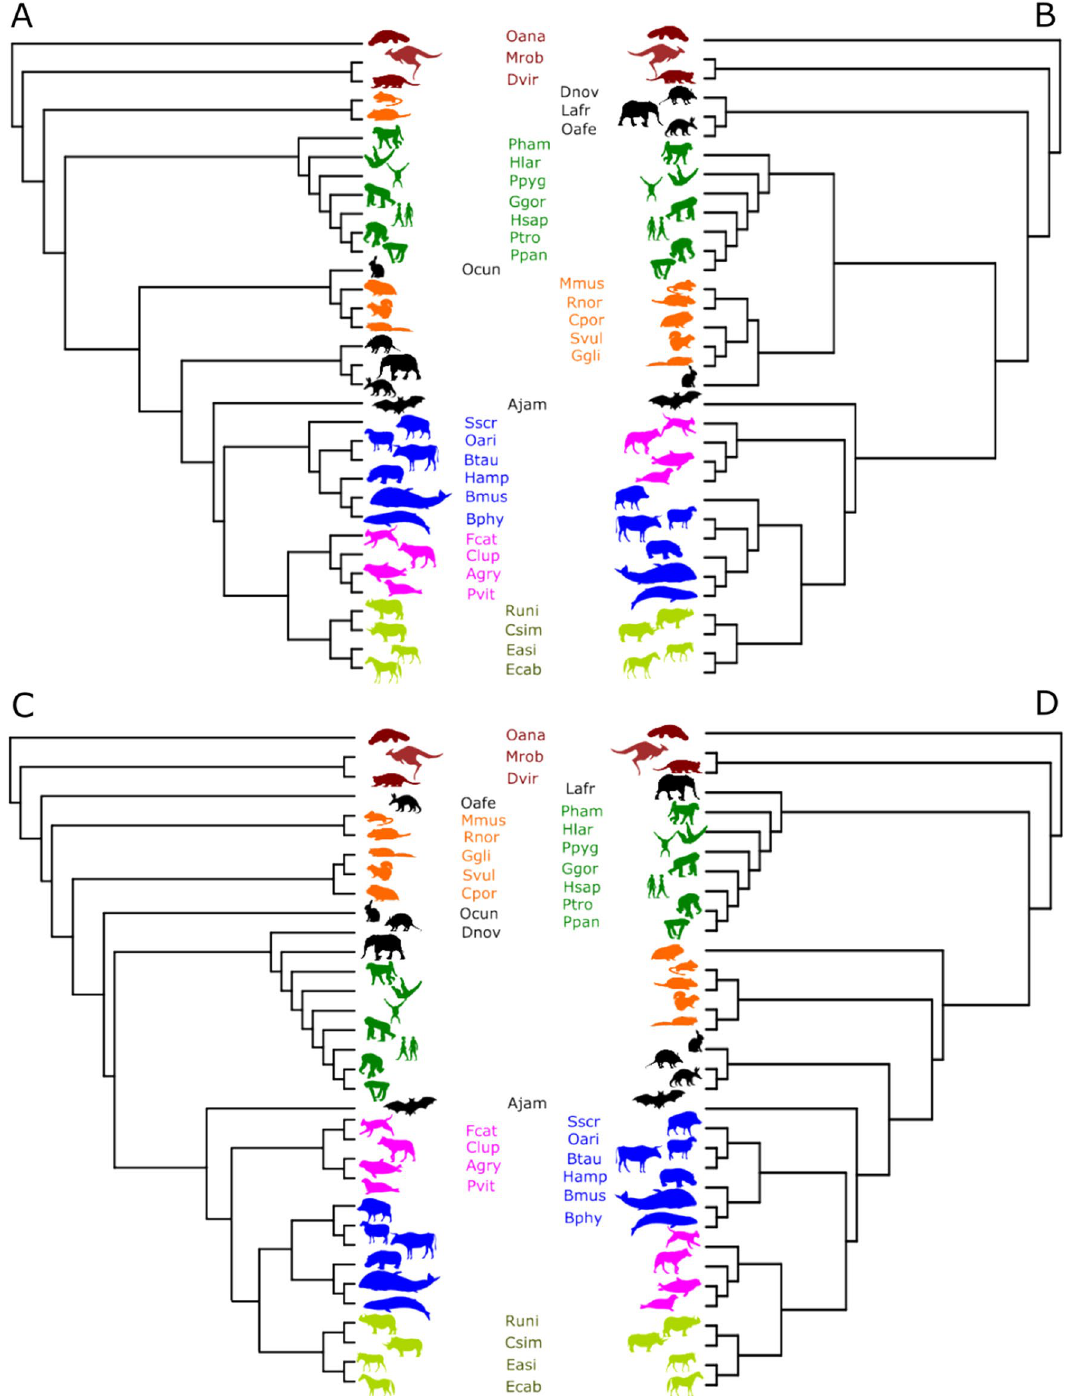
Figure 3. Comparison of phylogenetic tree topologies. The same mitogenomes of 34 mammalian species spanning 13 orders were employed with different tree-building methods. ( A ) Reproduces the topology of the tree obtained by Reyes et al. 2000 using a maximum likelihood approach based on multiple sequence alignments of nucleotides. (For protein genes, only first and second positions, P12, of the codons were considered. In addition, the ND6 gene encoded by the L-strand was also excluded). ( B ) The topology of the tree provided by VerLife 45 for the relevant species is drawn. ( C ) The topology of the tree obtained using Env-NJ with a radius of 46 and the Jensen-Shannon metric is shown. ( D ) The topology of the tree constructed using singular value decomposition (SVD) to analyzed 4-mer string frequencies derived from unaligned sequences is also